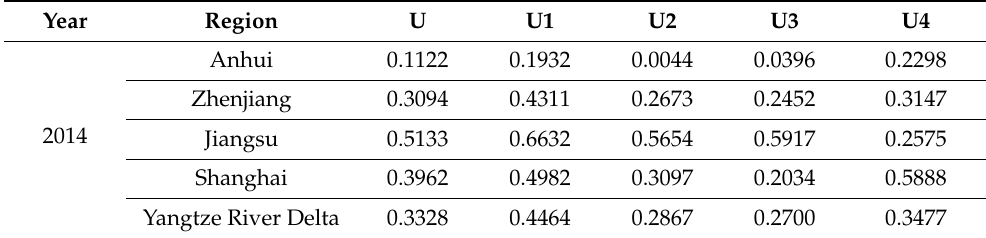
Table 4. Development and comprehensive development indices of the innovation